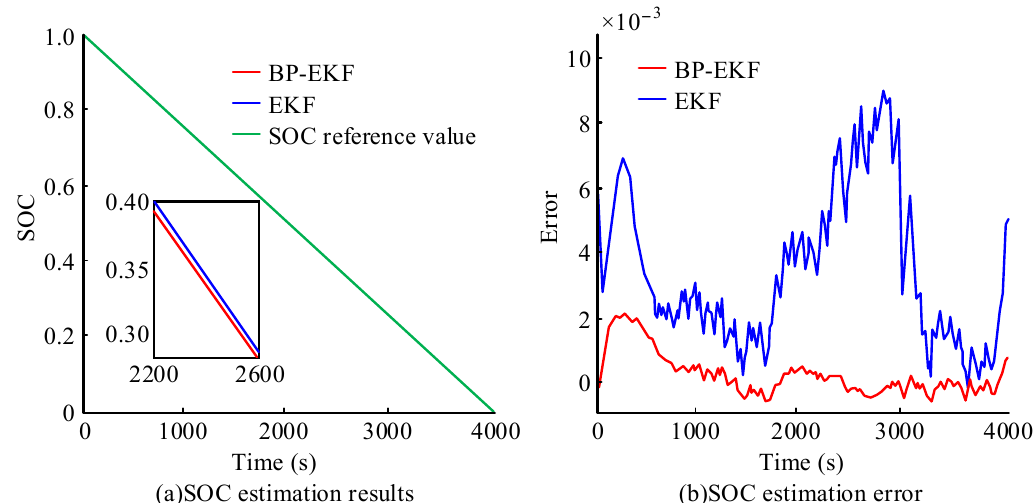
Figure 5. SOC estimation and error of the model under constant current discharge condition. As can be seen from Figure 5, the model’s SOC appraises are very close to the true values under constant current discharge conditions, and the model is able to converge accurately and quickly to approximate the true values, with a maximum error of 0.22% and an average error of 0.347% between the model’s SOC appraises and the true values’ accuracy. The SOC estimation results and errors of the model under pulse discharge con- ditions are shown in Figure 6.